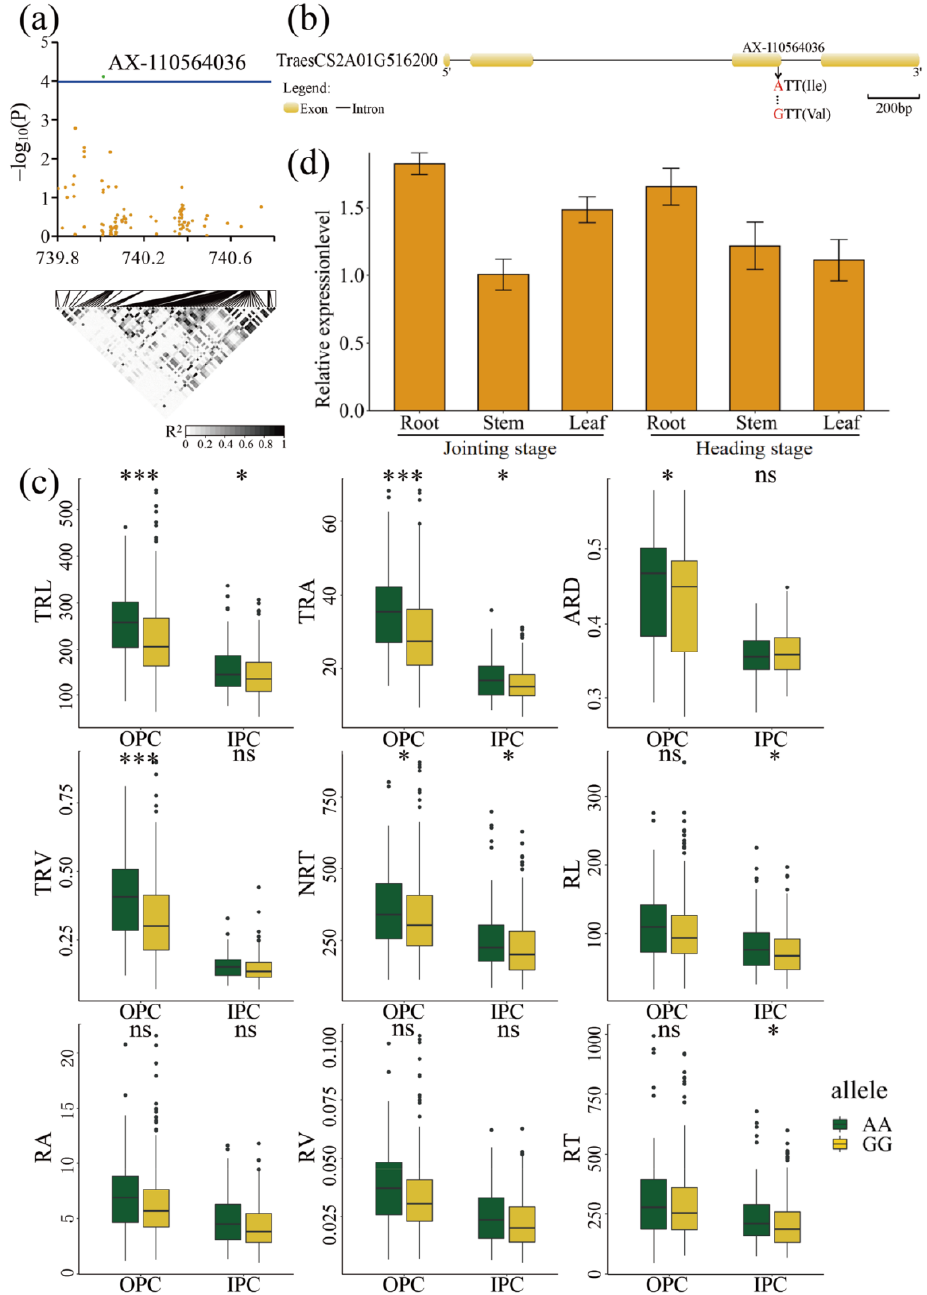
Figure 5. GWAS results of the nine RSA traits and identification of candidate gene for the SNP AX-110564036 on chromosome 2A. ( a ) Manhattan plot for the candidate region on chromosome 2A. The green dot represents the significant SNP AX-110564036. The LD block analysis of the SNPs in this region is shown below. The degree of linkage is represented by the coefficient of r 2 . ( b ) Gene structure of TraesCS2A01G516200 and its non-synonymous SNP. Yellow rectangles and black lines represent exons and introns, respectively. The arrow indicates the position of amino acid variations in TraesCS2A01G516200 . ( c ) Box plots for RSA traits based on the allele at SNP AX-110564036. Differences between the haplotypes were statistically analysed using the Student’s t -test. The upper and lower edges of the box represent the 75th and 25th quantiles, respectively, and the whiskers show the 90th and 10th quantiles; the horizontal solid line represents the average; * Significant at p ≤ 0.05, *** Significant at p ≤ 0.001. ( d ) Expression profile of TraesCS2A01G516200 in different tissues, as determined by RT-qPCR. The data are the means ± Sd of n = 3. ‘ns’ means ‘not